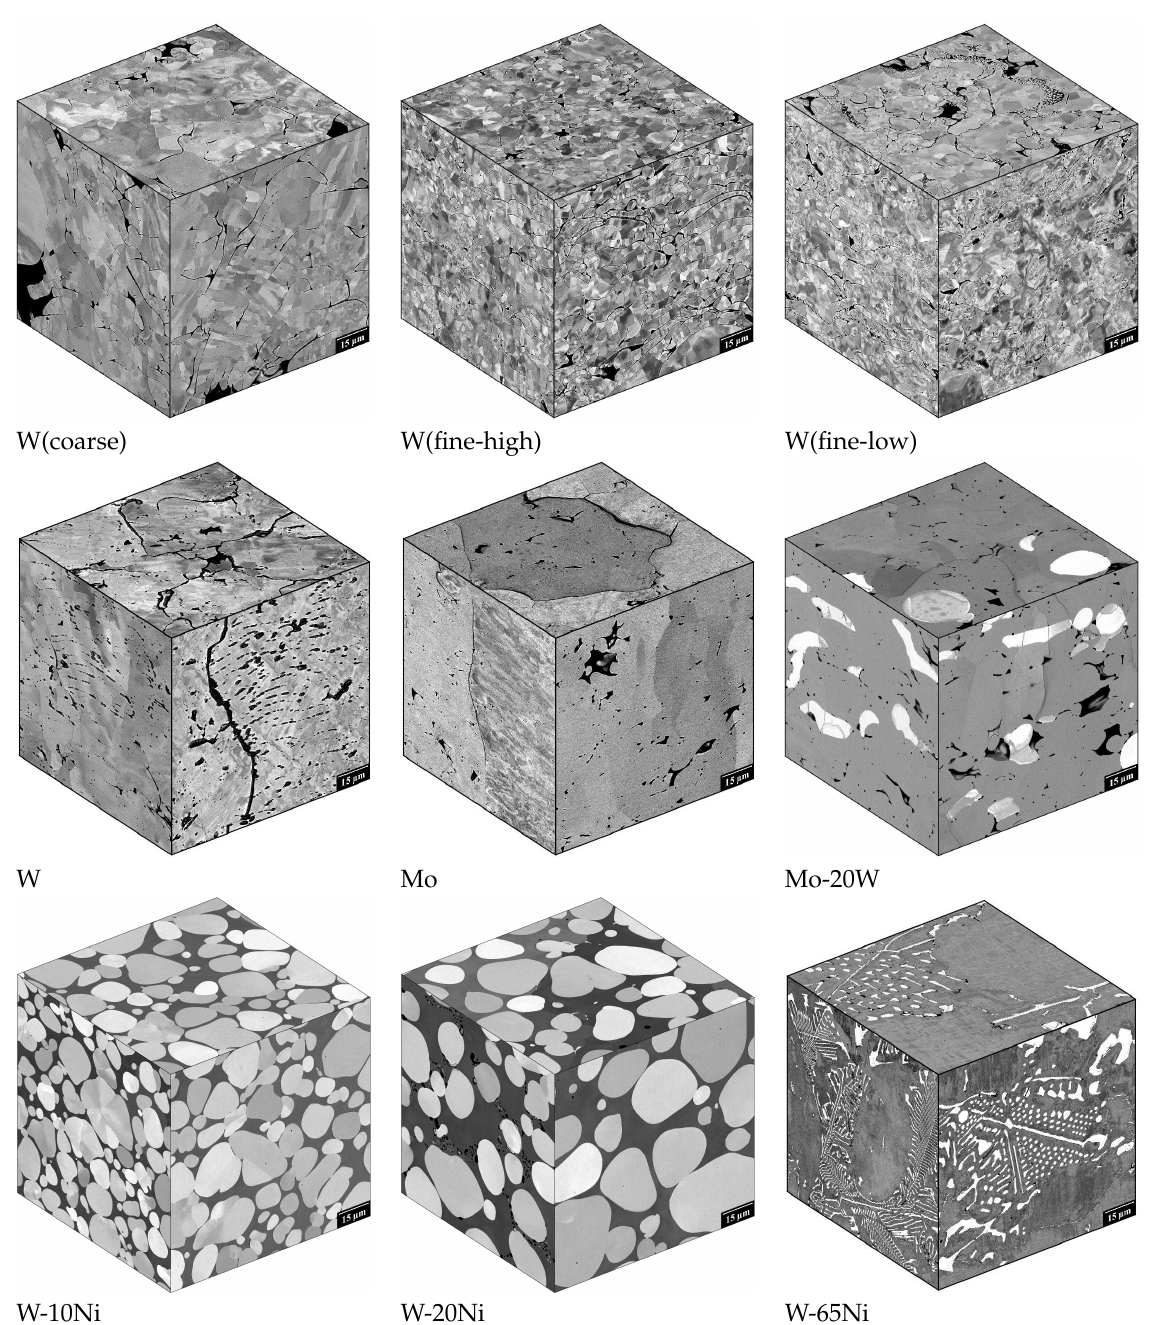
Figure 3. Pseudo-3D microstructures of the investigated refractory materials. The W and Mo deposits showed small globular pores chained along splat boundaries, narrow inter-splat pores, and larger irregular pores caused by unmelted or resolidified particles. The materials consisted of columnar grains spanning several layers of